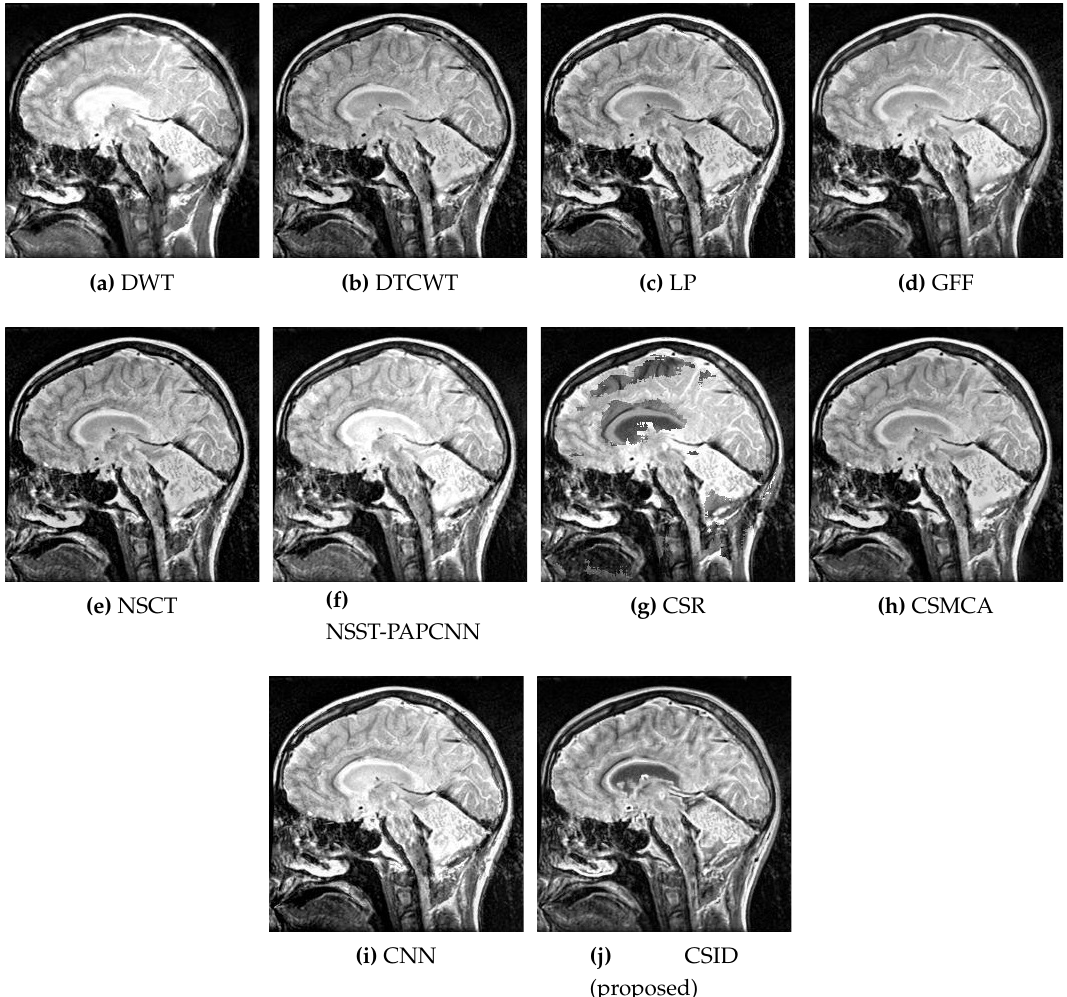
Figure 8. Comparative analysis, based upon visual observation, of the resultant fused images generated by the given set of algorithms using Data-4